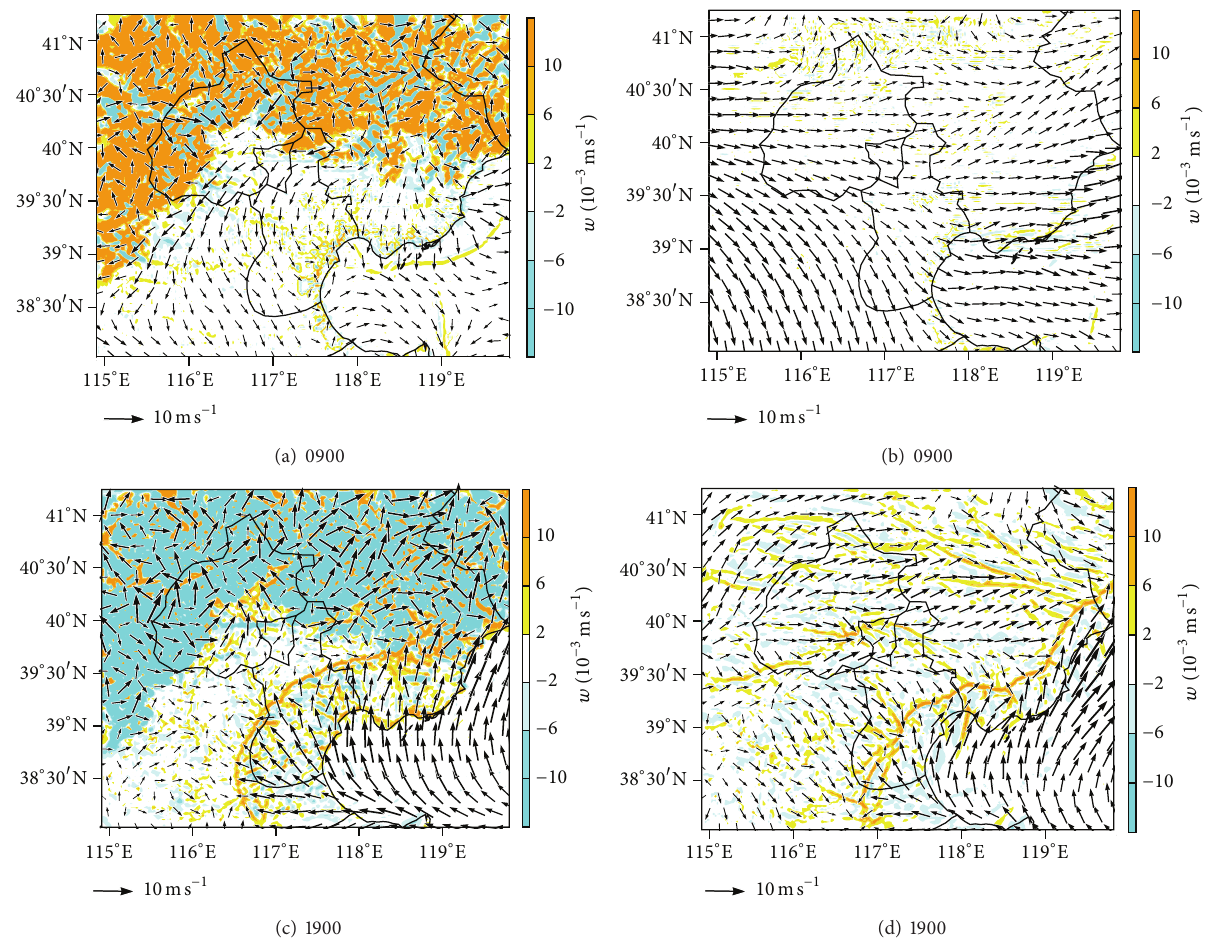
Figure 5: Simulated 10m wind field and the vertical wind component on the lowest vertical level at 0900 LST and 1900 LST 24 August, 2013; (a) and (c) CNTL and (b) and (d) FLAT. The location of sea breeze inland front can be indicated by the convergence zone with high vertical wind component ( 𝑤 ). Table 4: Summaries of the evaluation parameters of the vertical cross section from A to B in Figure 1(b). CNTL FLAT RURAL REAL Sea breeze start time 0800 LST 1200 LST 0800 LST 0800 LST Sea breeze end time 0200 LST 2100 LST 0200 LST 0100LST 110km, 31 km, Maximum inland penetration distance and the time 2200 LST 2200